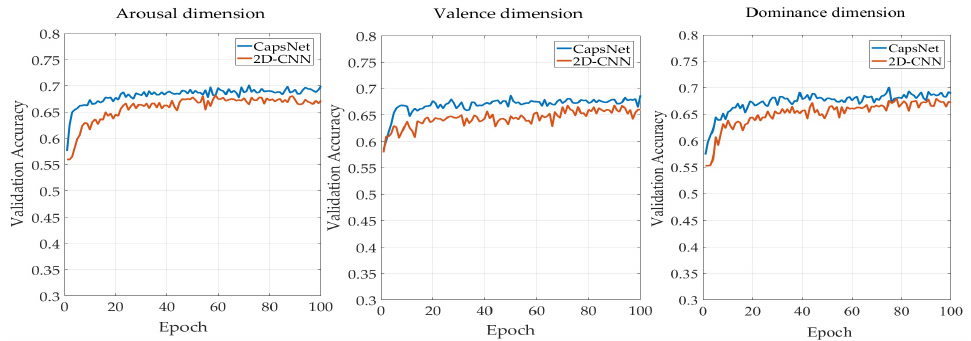
Figure 10. Comparison of 2D-CNN and CapsNet using multiband feature matrices (MFMs).